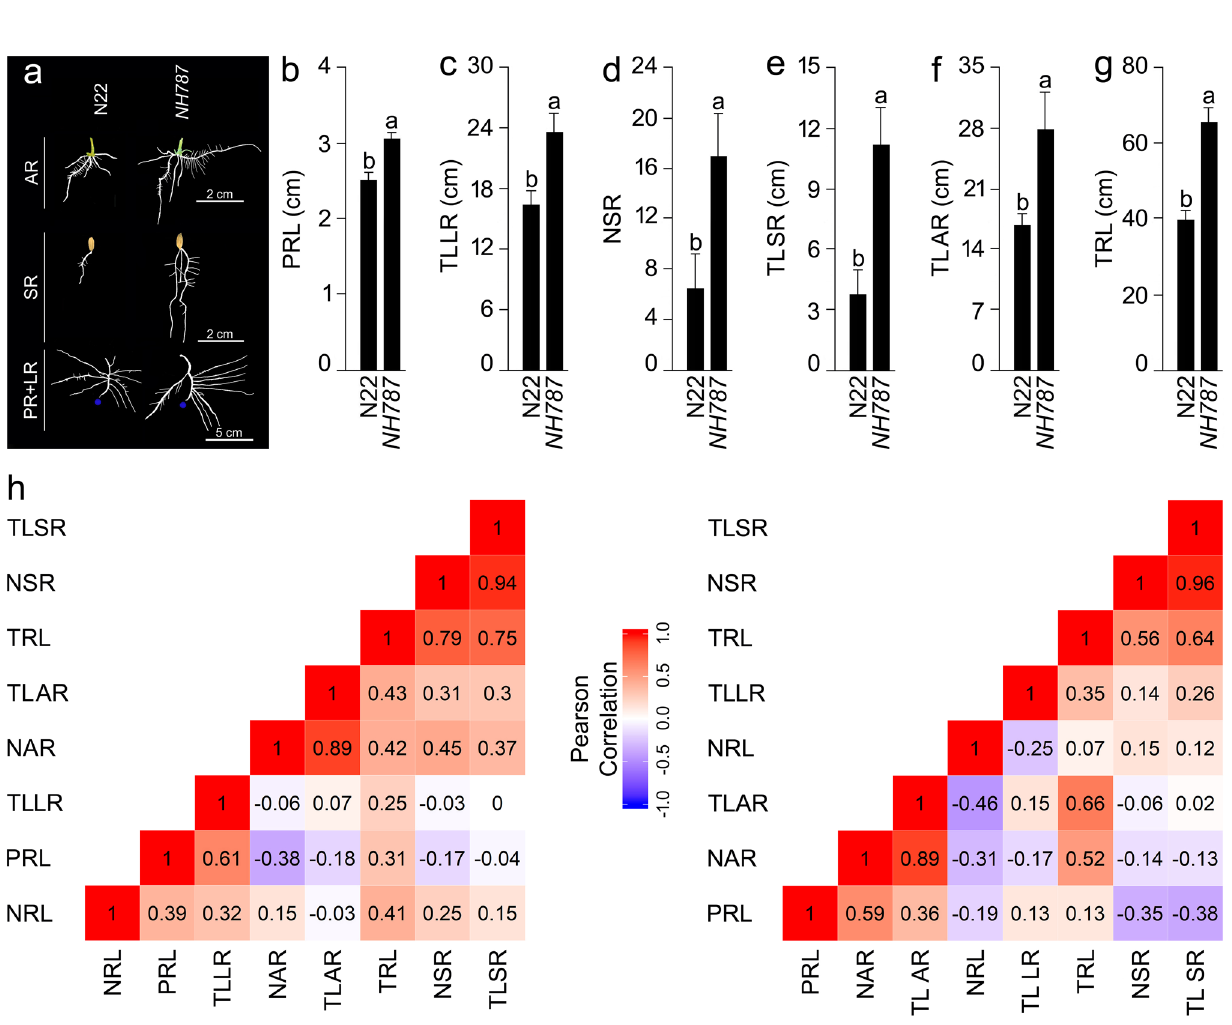
Effects of different Pi regimes on various morpho-agronomic traits of N22 and NH787 grown to maturity in potting soil. Growth performance and morpho-agronomic traits of N22 and NH787 plants grown to maturity (50% flowering) in Pi-replete (P+) and low Pi (P−) potting soil were determined (Fig. S3, Fig. 3). Pi deficiency exerted inhibitory effects on various morpho-agronomic traits of both N22 and NH787 , which resulted in stunted phenotype, and significant reductions in the root biomass (N22 [88.37%], NH787 [24.59%]), vegetative biomass (N22 [73.48%], NH787 [12.03%]), filled spikelets/panicle (N22 [50.18%], NH787 [17.53%]), 100-grain weight (N22 [25.00%], NH787 [8.69%]), and yield (N22 [83.08%], NH787 [23.59%]) (data not shown). Whereas, during Pi deficiency, the unfilled spikelets/panicle was significantly higher in N22 (52.74%) but was comparable in NH787 with P+ condition (data not shown). It was evident from the analysis that the effects of Pi deprivation were relatively more aggravated in N22 than NH787 . Earlier studies also reported the inhibitory effects of Pi deficiency on various morpho-agronomic traits of N22 and its EMS mutants 42–44,46,47,71 . Under P+ condition, there was no apparent difference in the phenotype of N22 and NH787 (Fig. S3A). However, the phenotype of the root, panicles, and grain was more robust in NH787 compared with N22 (Fig. S3B-D). This was reflected in significantly higher root biomass (41.86%), vegetative biomass (19.70%), filled spikelets/panicle (89.79%), 100-grain weight (15.00%), and yield (36.96%) of NH787 compared with N22 (Fig. S3E–G,I,J). On the contrary, unfilled spikelets/panicle was significantly higher (61.64%) in N22 compared with NH787 (Fig. S3H). However, under P+ condition the root length and number of tillers in N22 and NH787 were comparable (data not shown). Further, Pearson analysis revealed a positive and significant correlation of yield with root and vegetative